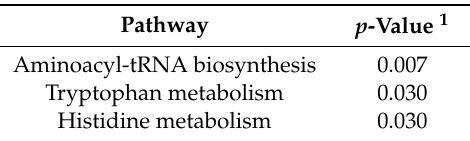
Table 1. Pathway enrichment